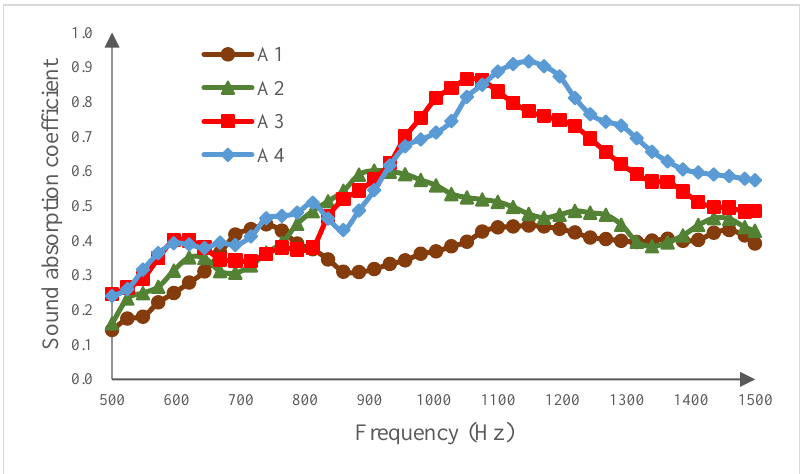
Figure 2. Sound absorption coefficient spectrum.